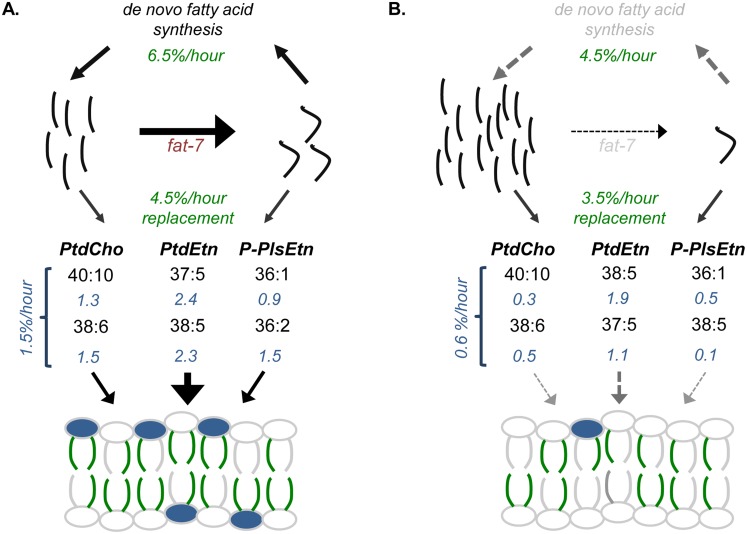
Modeling the Impact of SCD Depletion on Membrane Dynamics.(A) 13C-tracers allow for the quantification of de novo synthesis as well as incorporation of FAs into PLs (measurements from 13C-tracers shown in green). Our implementation of 15N to measure PL headgroup turnover defines the rates that the two most abundant species within each major PL class are replaced (shown in blue); for example, 40:10 and 38:6 are the largest contributors to the PtdCho pool and are replaced at a rate of 1.3% new PL/hour and 1.5% new PL/hour respectively. A weighted average of the PL replacement calculated for the PL species reported here predicts that 1.5% of the total PLs are replaced each hour. We combined the PL replacement rates with those calculated for FA tails where we found that 4.5% of measured fatty acid tails are new each hour. The quantification after 24 hours revealed a stable population of membrane lipid (see S3 Fig); thus, we reduced our average fatty acid predictions by 30% to account for that population. Taken together, we use the 13C and 15N-tracers to define how the individual lipid components (FA tails and polar headgroups) are replaced over time, and predict that at least 60% of the membrane is new each day when considering each fatty acid tail and headgroup as individual entities. (B) Upon fat-7 RNAi treatment, there is a buildup of C18:0 and a depletion of C18:1n9, which in turn reduces the activation of de novo FA synthesis. Subsequently, FAs provided to PL synthesis and ultimately provided to the membrane, are severely compromised.